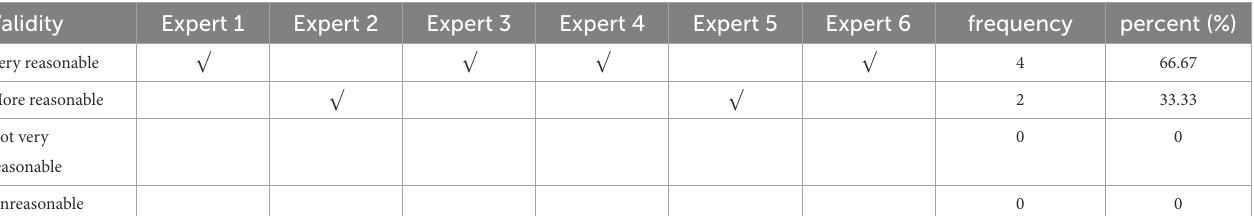
TABLE 2 Statistical table for questionnaire validity test.